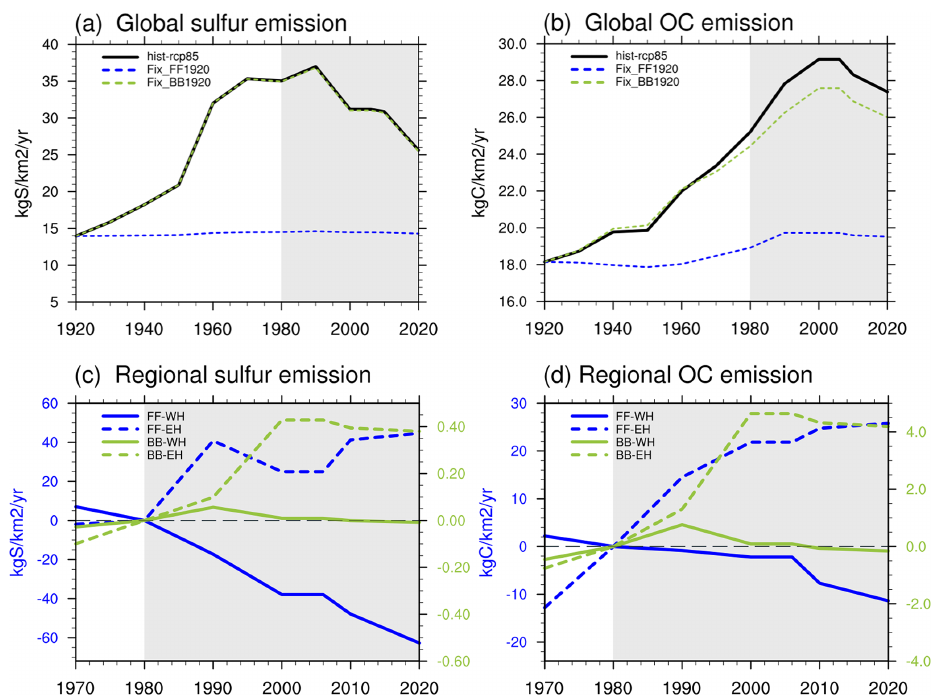
Figure 1. Panels (a) and (b) show the global average anthropogenic emission of sulfur and OC from 1920 to 2020 in the three sets of simulations used in this study. FF represents the emission related to fossil fuel. BB represents biomass burning. The shaded areas of 1980– 2020 are the period focused on in this study. Panels (c) and (d) are similar to (a) and (b) but with the difference between ALL and the corresponding fixed aerosol experiments indicated to show the regional FF or BB emissions. FF (blue lines) uses the left-hand side y axis and BB (green lines) uses the right-hand side y axis. Solid lines are for the western box (west box; 0–80 ◦ N, 120 ◦ W–40 ◦ E), and dashed lines are for the eastern box (east box; 0–80 ◦ N, 60–150 ◦ E). Boxes are shown in Fig. 2. All numbers in panels (c) and (d) are relative to the 1980 level to illustrate the change from 1980 to